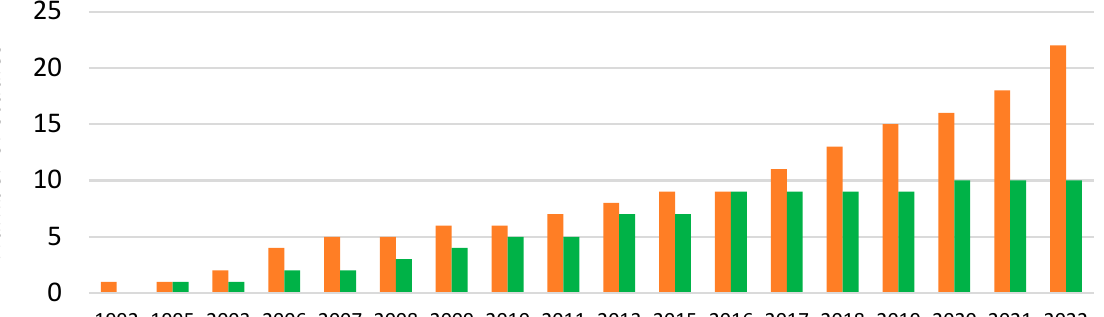
Figure 4. Number of published studies for the Azores and the Canaries over time.